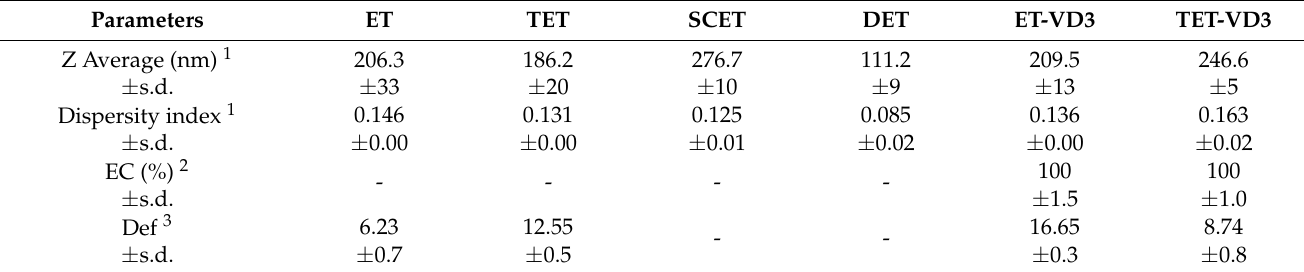
Table 2. SizedistributionparametersofETandtransethosomes, entrapmentcapacityanddeformabilityoftheindicatedformulations.